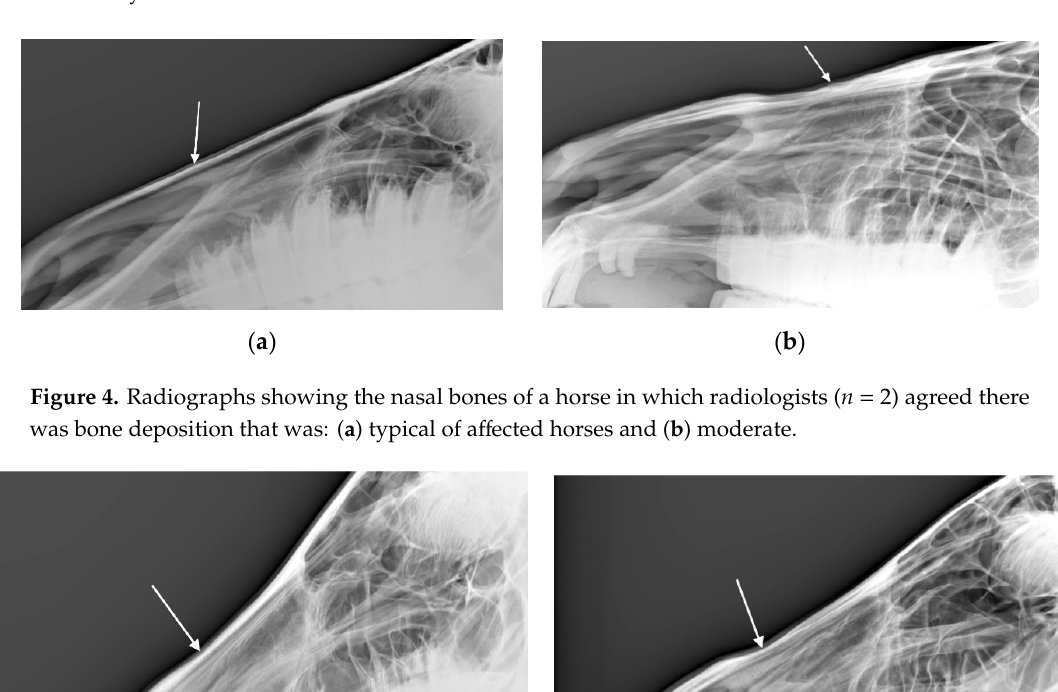
Figure 4. Radiographs showing the nasal bones of a horse in which radiologists ( n = 2) agreed there was bone deposition that was: ( a ) typical of affected horses and ( b ) moderate.